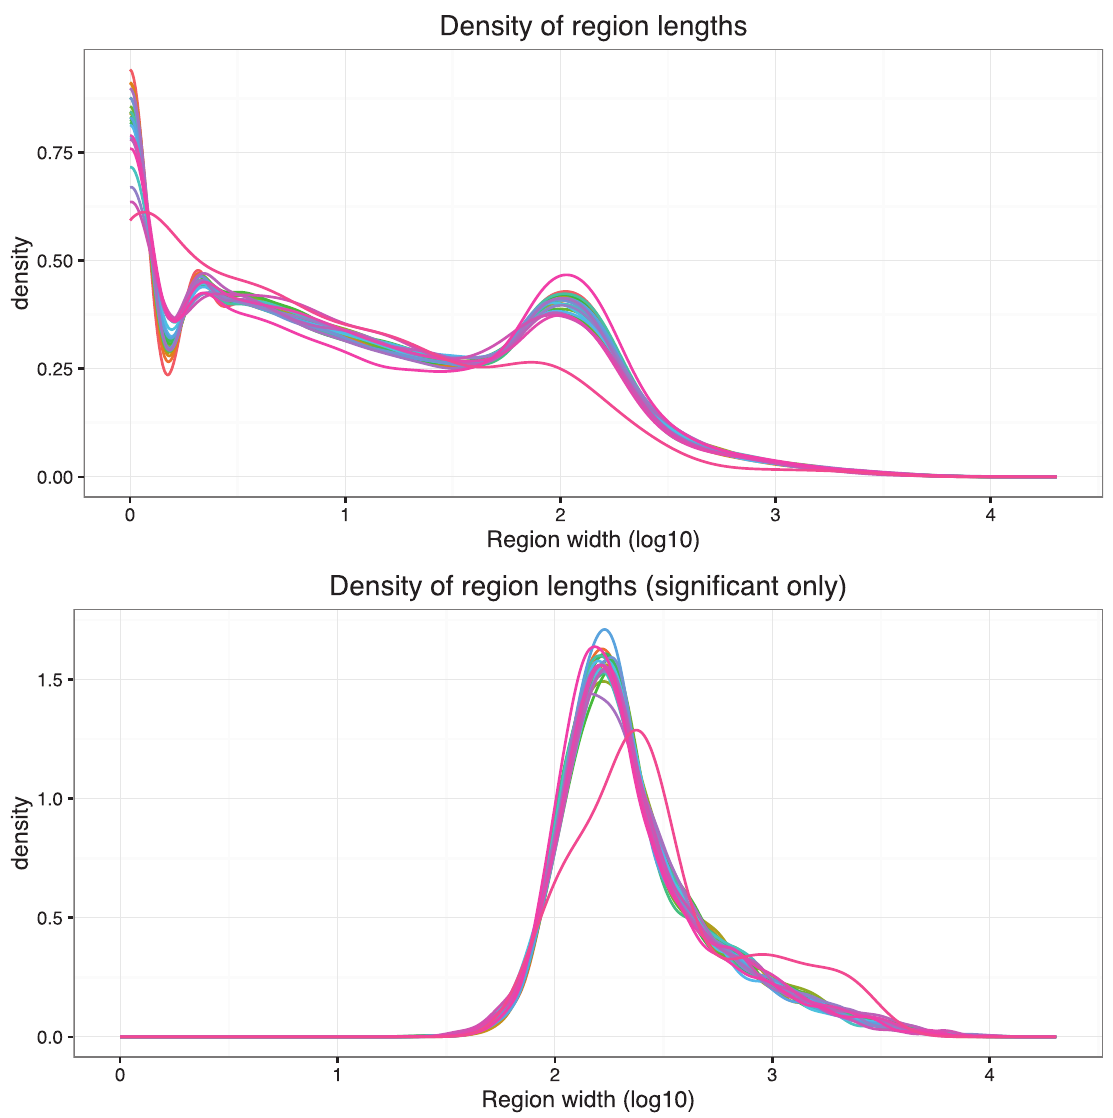
Figure 3. Distribution of region widths for all regions in the derfinder use case example with the BrainSpan dataset. The top figure shows the region width distribution for all regions while the bottom one shows it only for the significant regions. One line is shown per chromosome in each of the